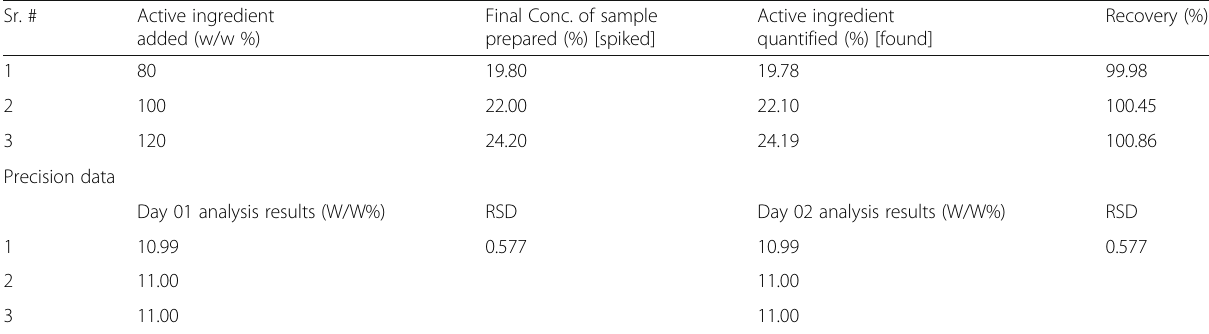
Table 3 Data for accuracy and precision studies